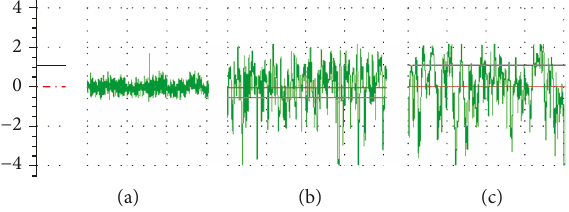
Figure 14: Roughness measured from three di ff erent surface patterns.